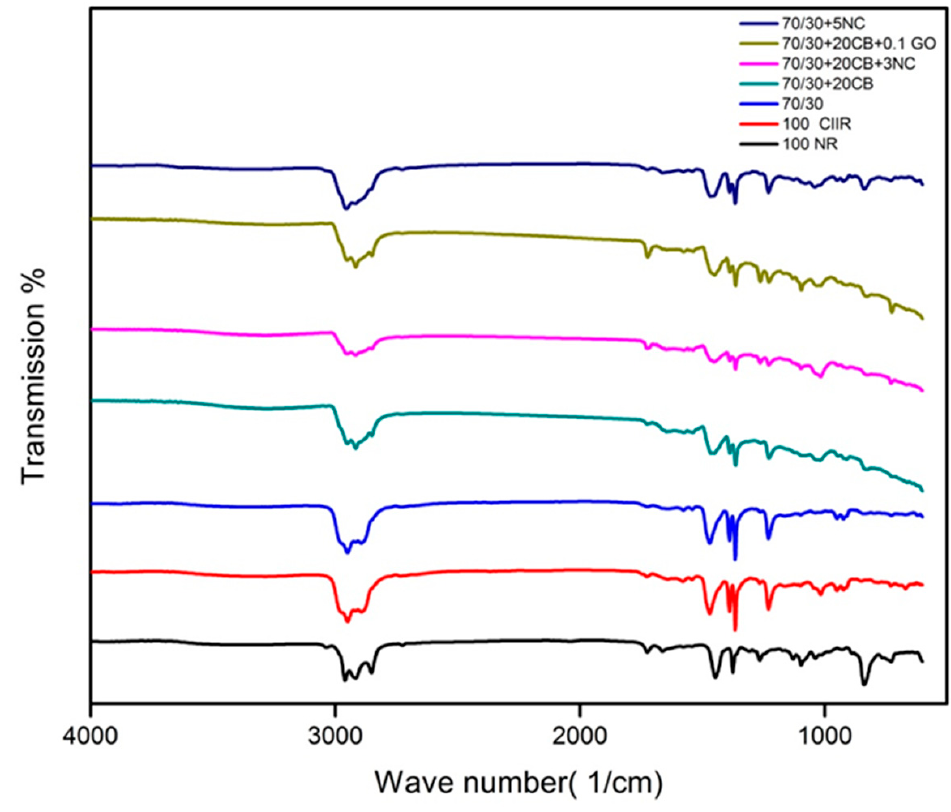
Figure 4. FTIR spectra of polymer nanocomposites.